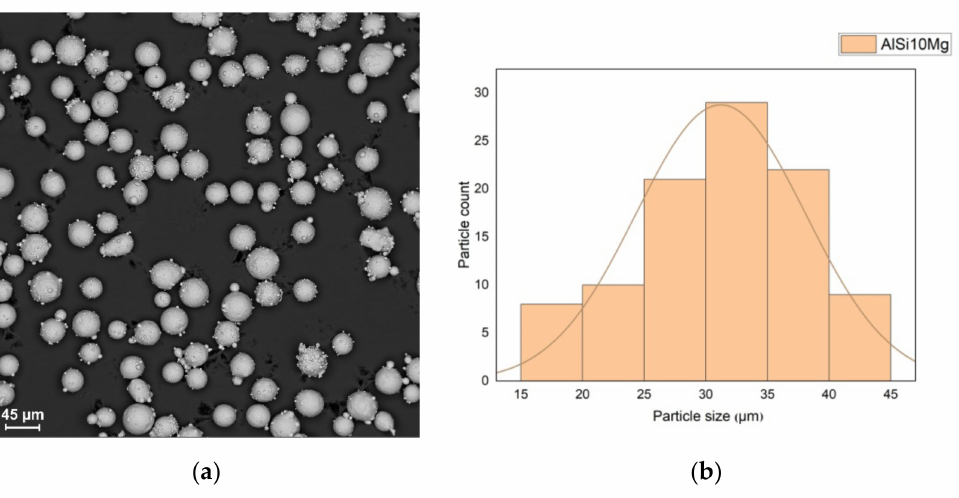
Figure 2. Particle size analysis: panoramic BSE image ( a ) and particle size distribution ( b